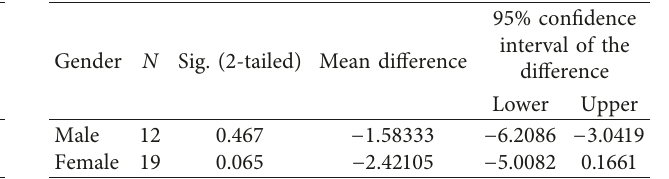
Table 3: Statistic and one-sample t -test for depersonalization with reference to gender.